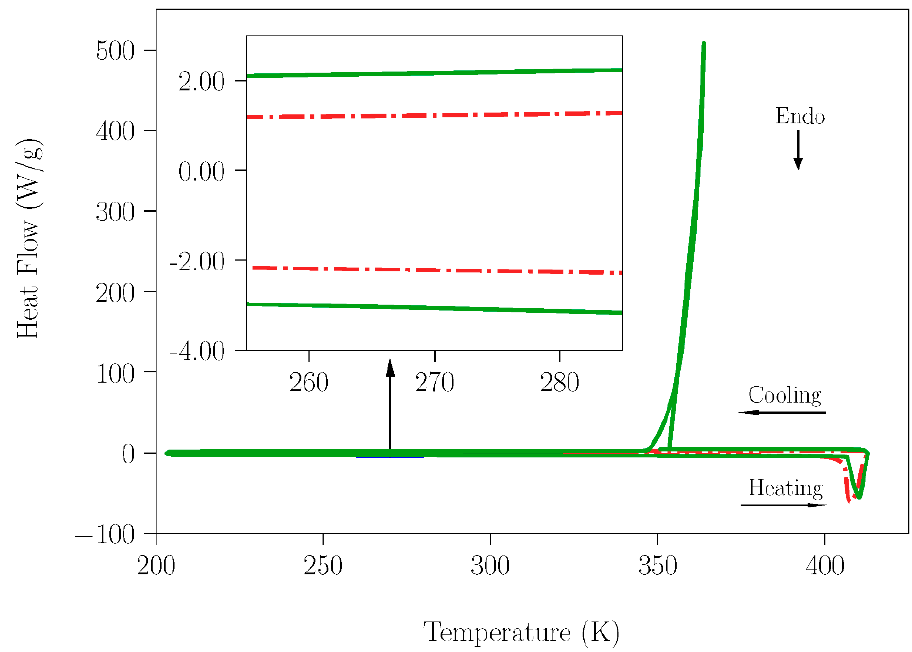
Figure 3. DSC measurement for the TRIS samples; one stored under laboratory moisture for 4 months (red and dash solid line) and the second under dry conditions (green and solid line). The heating rate used was 10 K·min − 1 .